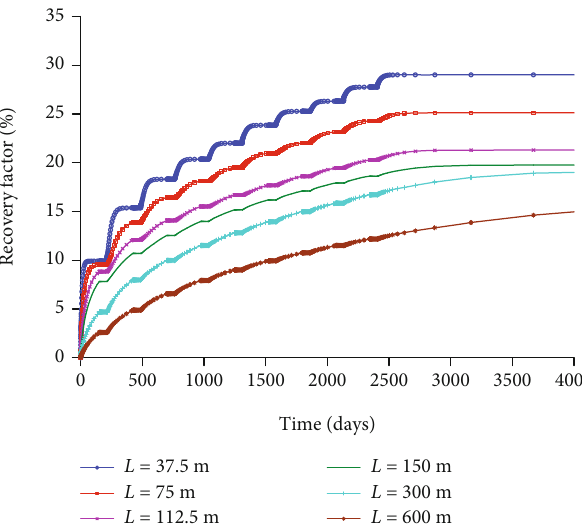
Figure 11: Production curves of reservoirs with di ff erent fracture spacing distances by cyclic surfactant injection.